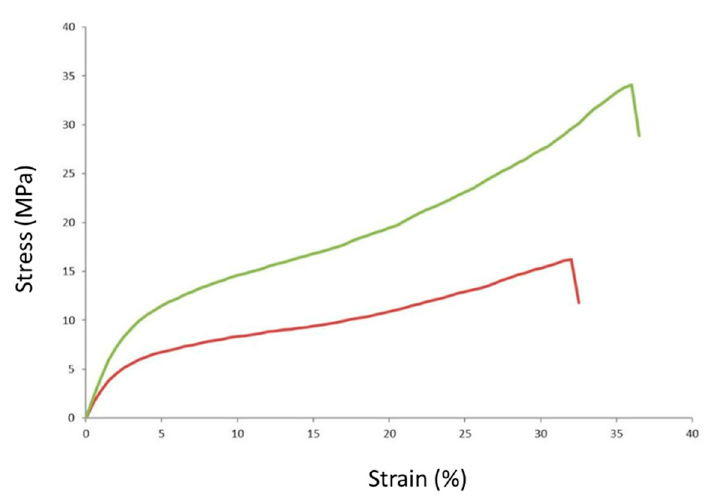
Figure 3. Stress–strain curves of PVA/ST/WMRE (top) and control PVA/ST (bottom) films. Food products are more susceptible to spoilage when they are exposed to high mois- ture. Therefore, it is necessary for food packaging to have a good barrier towards